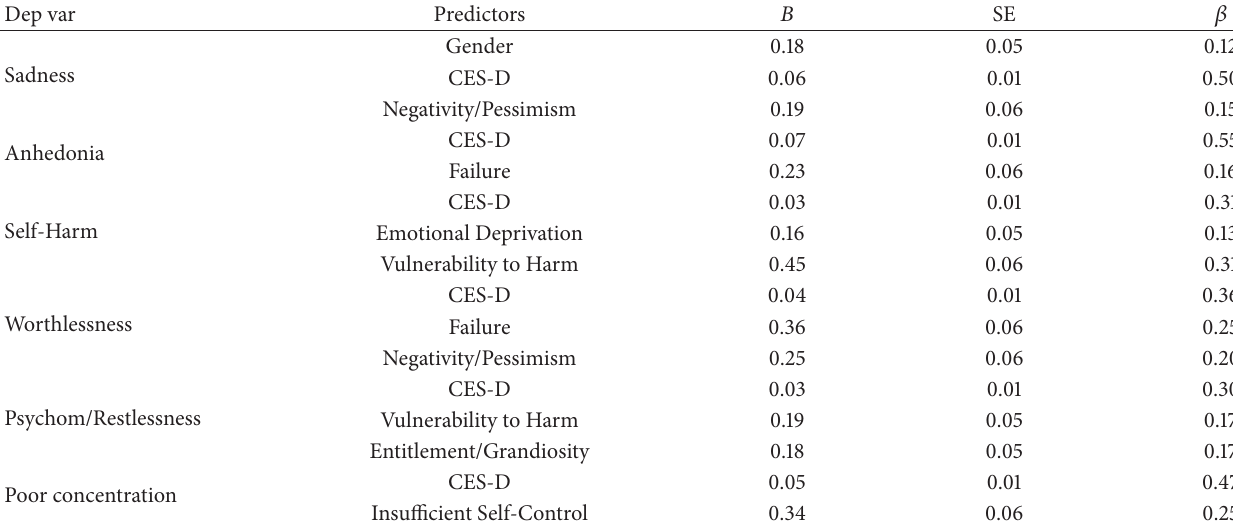
Table 4: Final steps ( 𝑃 -to-enter = 0.0025) of the stepwise regression models of EMSs predicting symptoms scores ( 𝑛 = 456 ). Dep var Predictors 𝐵 SE 𝛽 Gender Sadness